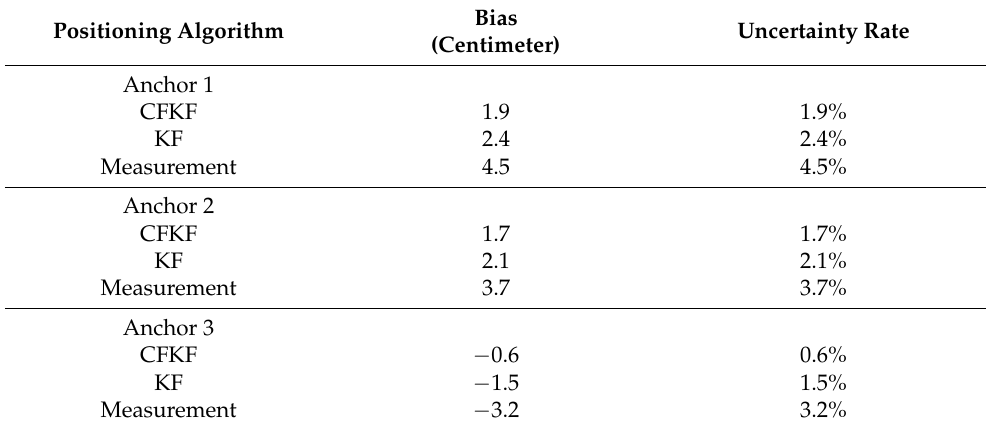
Table 3. Algorithm bias table for UWB anchor 1–3.